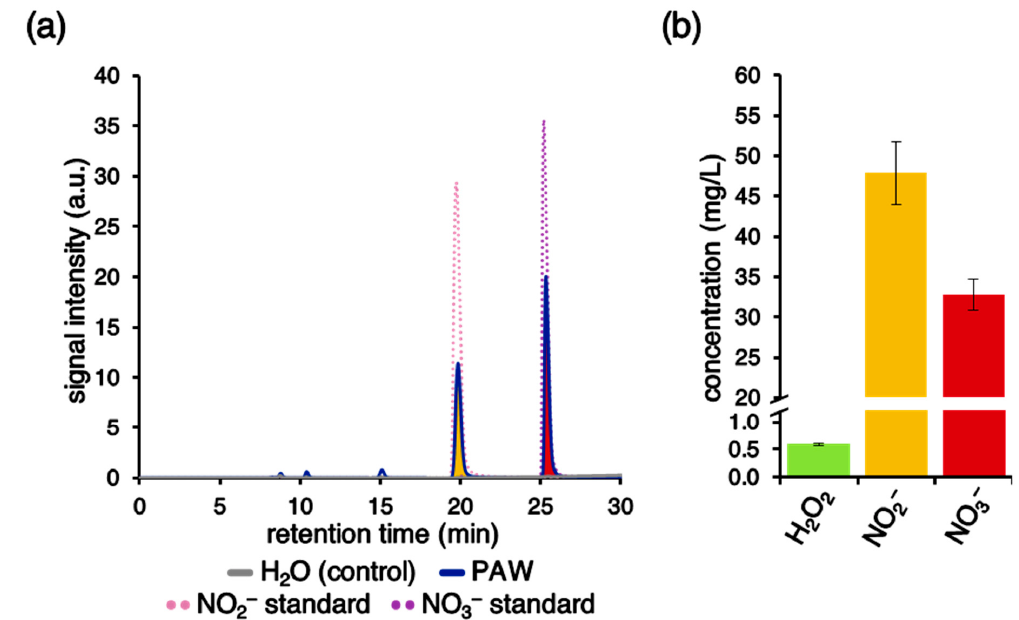
Figure 6. Chemical analyses for the detection of reactive oxygen and nitrogen species (RONS) in PAW. ( a ) Undiluted PAW (blue) generated by exposing deionized H 2 O to cold plasma for 5 min at 900 W torch #1 power was analysed by ion chromatography. Deionized H 2 O (grey) was used as a control. NO 2 − (pink) and NO 3 − (purple) solutions were used as standards. Representative traces are shown. ( b ) Determination of H 2 O 2 (green), NO 2 − (yellow), and NO 3 − (red) concentrations in PAW generated in six different batches.